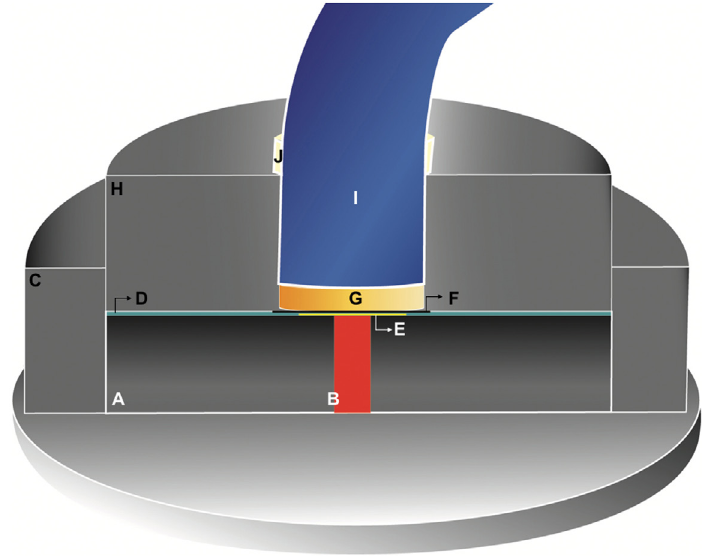
Figure 3- Schematic of the device coupled to the spectrophotometer (longitudinal section). A: Spectrophotometer. B: Spectrophotometer sensor through which the infrared light beam passes. C: Larger ring used to stabilize the spacer strip. D: spacer strip (0.1 mm thick). E: Cement on the diamond surface of the spectrophotometer. F: Polyester strip to prevent direct contact of the cement with discs. G: Ceramic disc. H: Smaller ring that holds the ceramic disc and the tip of the light-curing unit in position. I: Tip of the light-curing unit embedded in the smaller ring and positioned on top of the ceramic disc. J: "Stop" used to standardize the distance of 2.0 mm between the light-curing unit and the cement without the interposition of the ceramic